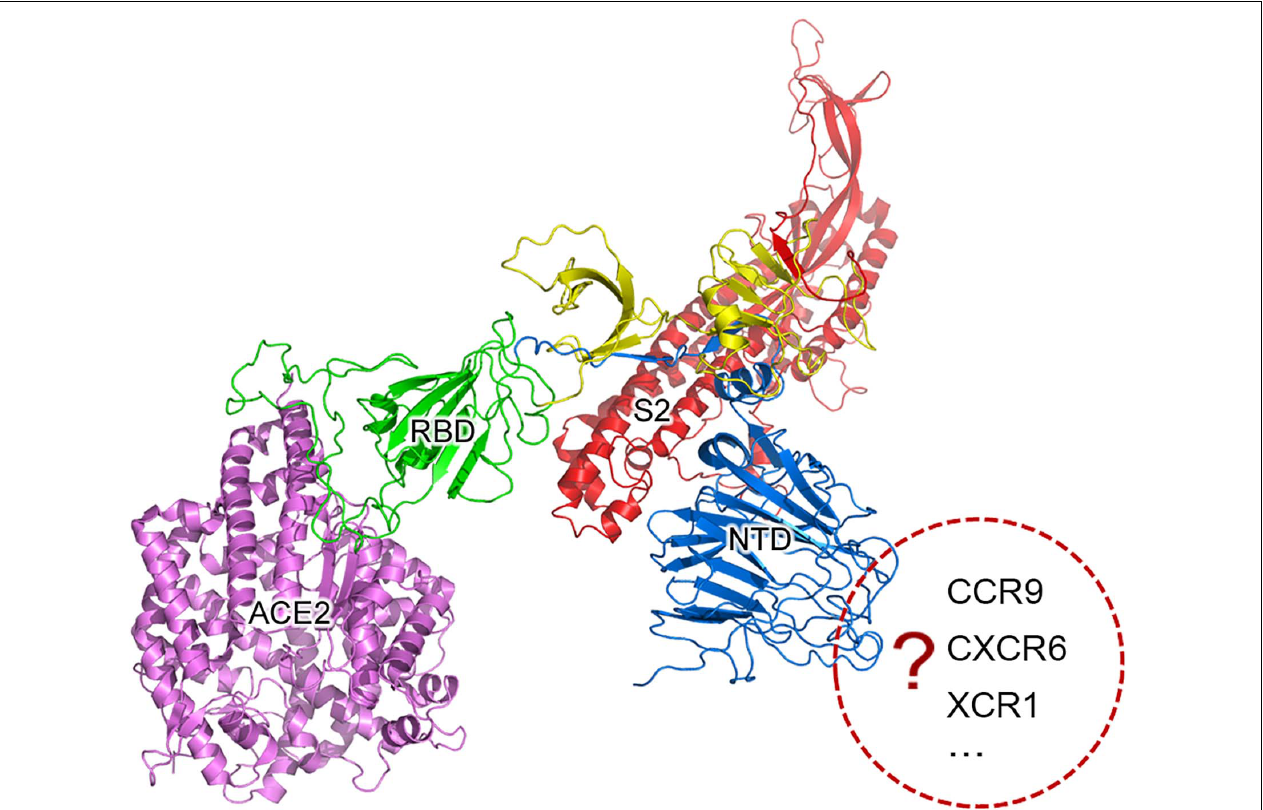
FIGURE 1 | SARS-CoV-2 may have more than one specific receptor. The S protein is cleaved into two subunit S1 and S2 (in red color) for receptor binding and membrane fusion. S1 has two domains, RBD (in green color) and NTD (in blue color). It is well accepted that S1 binds to its specific receptor angiotensin-converting enzyme 2 (ACE2) by the interaction between RBD and ACE2 (in purple color). In the present study, we propose that the S protein of SARS-CoV-2 may have more than one specific receptor for its function like gp120 of HIV has CD4 and CCR5. The structure of S was predicted using trRosetta (Yang et al., 2020).